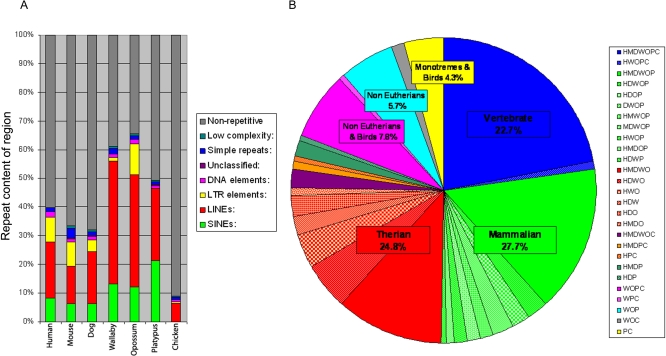
The Genome Landscape and ECRs(A) Repeat content of the DLK1-DIO3 region in seven vertebrates. The region in both marsupials contains greater than 60% repeats, most of which are LINE1s. The platypus region contains approximately 50% repeats—this is a higher proportion than identified in the eutherian domain despite the region being 28% smaller in platypus. The platypus domain is depleted in LTR repeats.(B) Distribution of the 141 ECRs identified. ECR groups are arranged according to the sub-classes of vertebrates they are identified in. Vertebrate: identified in at least one eutherian, one marsupial, platypus, and chicken. Mammalian: identified in at least one eutherian, one marsupial, and platypus. Therian: identified in three therians including one eutherian and one marsupial. H, human; M, mouse; D, dog; W, wallaby; O, opossum; P, platypus; C, chicken.